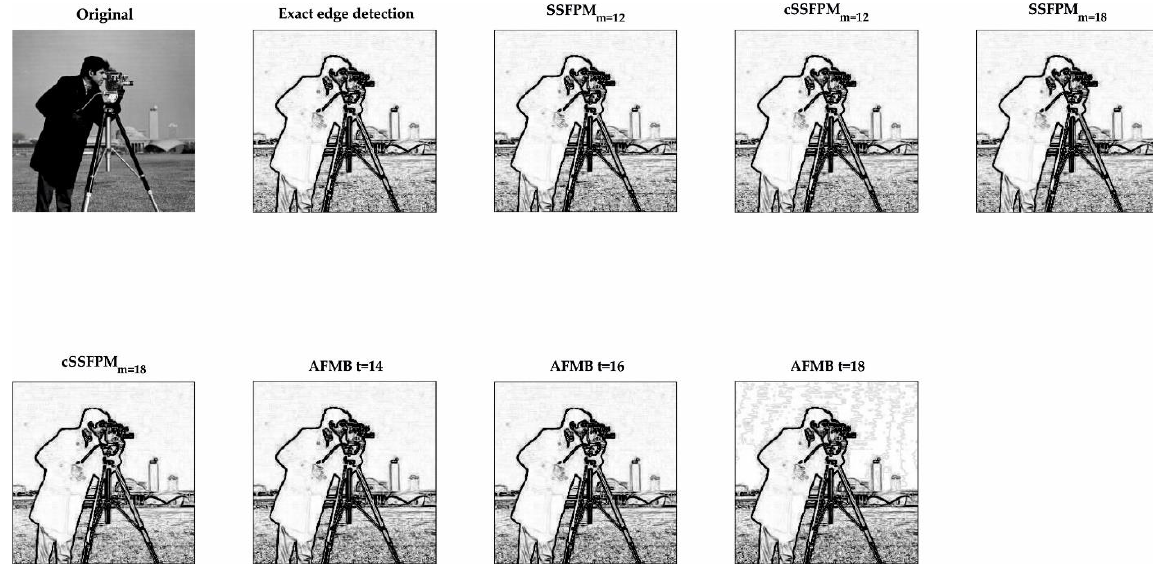
Figure 9. Results of the edge detection for the Cameraman image.